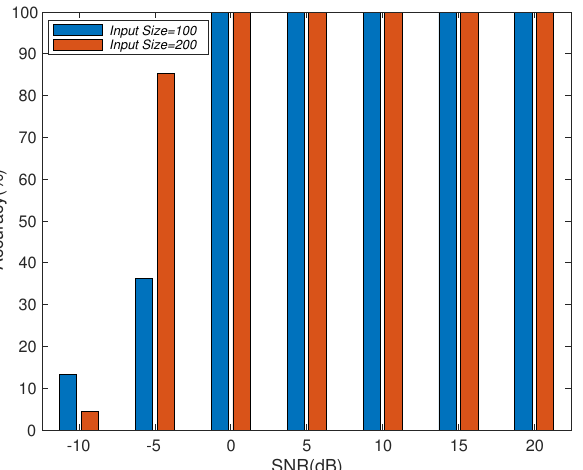
Figure 6. Comparison of accuracy with different input sizes for the parallel multilayer classifiers in CAE.